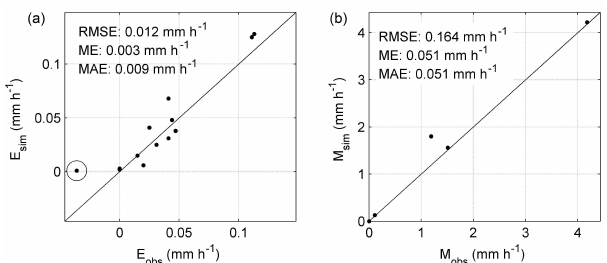
Figure 4. Measurements versus model estimates of evaposublima- tion ( E ) and melting ( M ) for the different test periods using a con- stant z 0 of 0.61mm. Each plot includes the root mean square error (RMSE), the mean error (ME), and the mean absolute error (MAE). The line indicates a 1:1 relationship between observed (obs) and simulated values (sim).